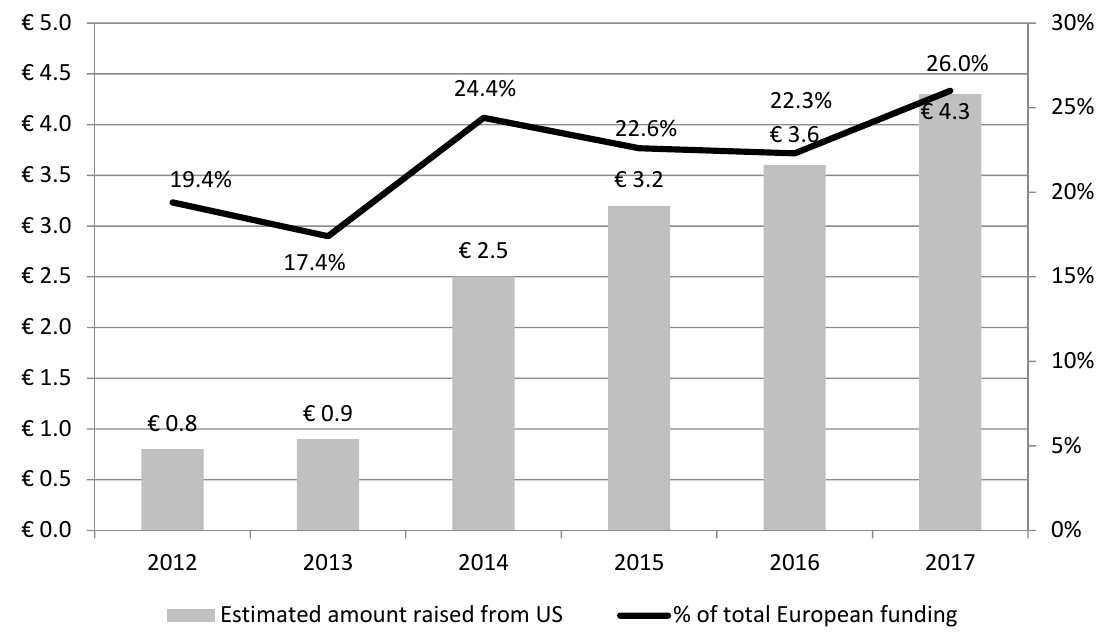
Figure 1. US investment in Europe by amount invested ( € B) (Dealroom.co 2018).